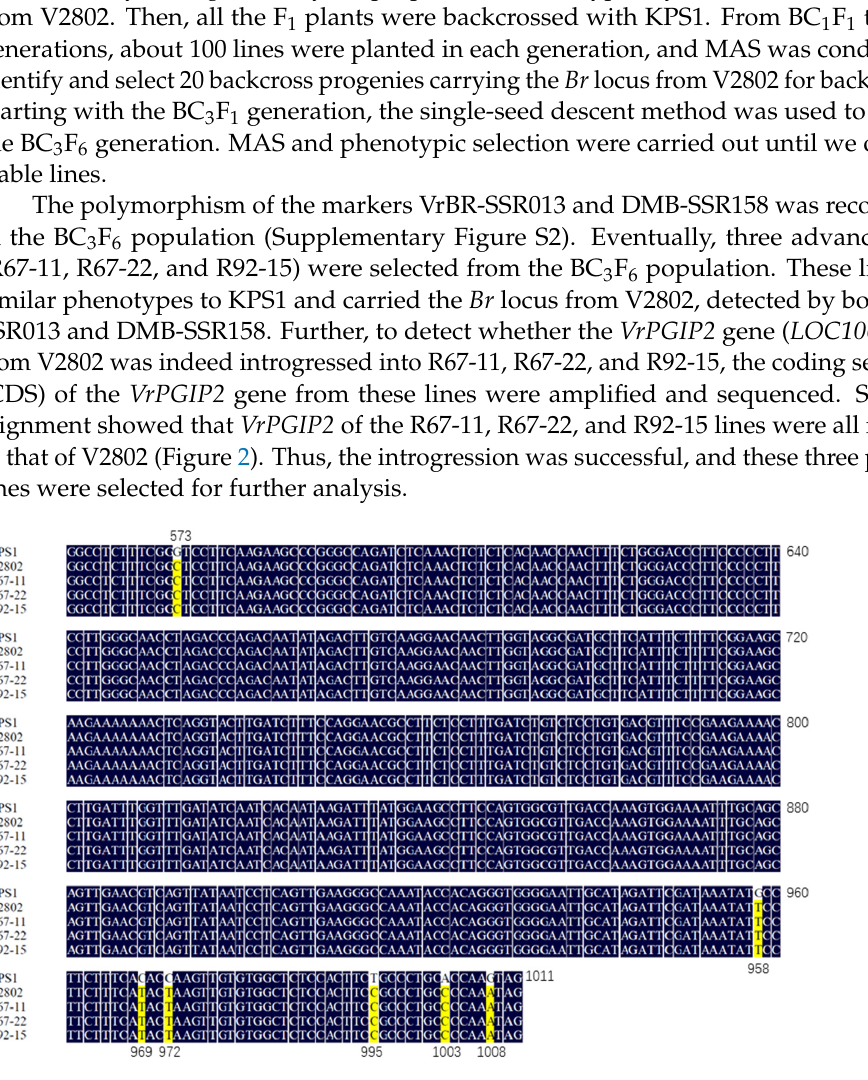
Table 1. C. maculatus resistance in advanced backcross lines and their parents. Genotype